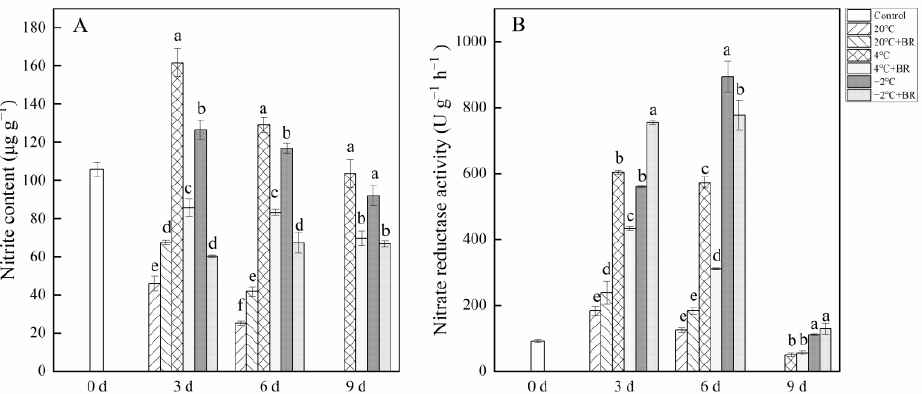
Figure 1. Appearance changes of T. sinensis as affected by BR treatment during different temperature storage.